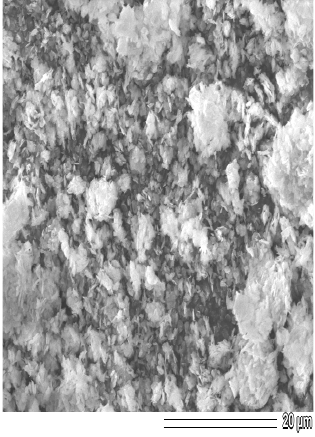
Figure 6. SEM image of NZnO.